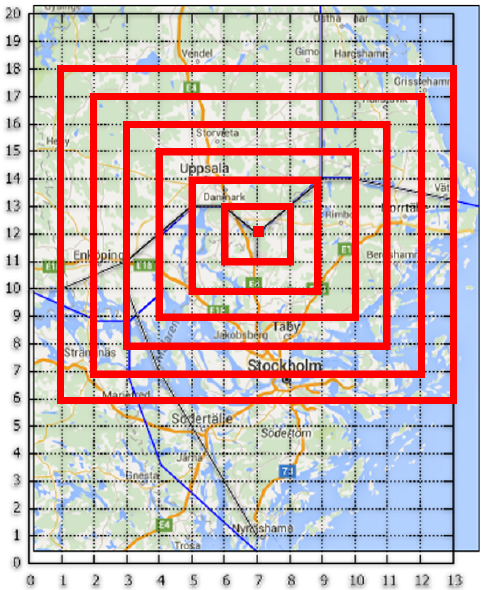
Figure 7. The configuration for the Stockholm instance with 7 of the 13